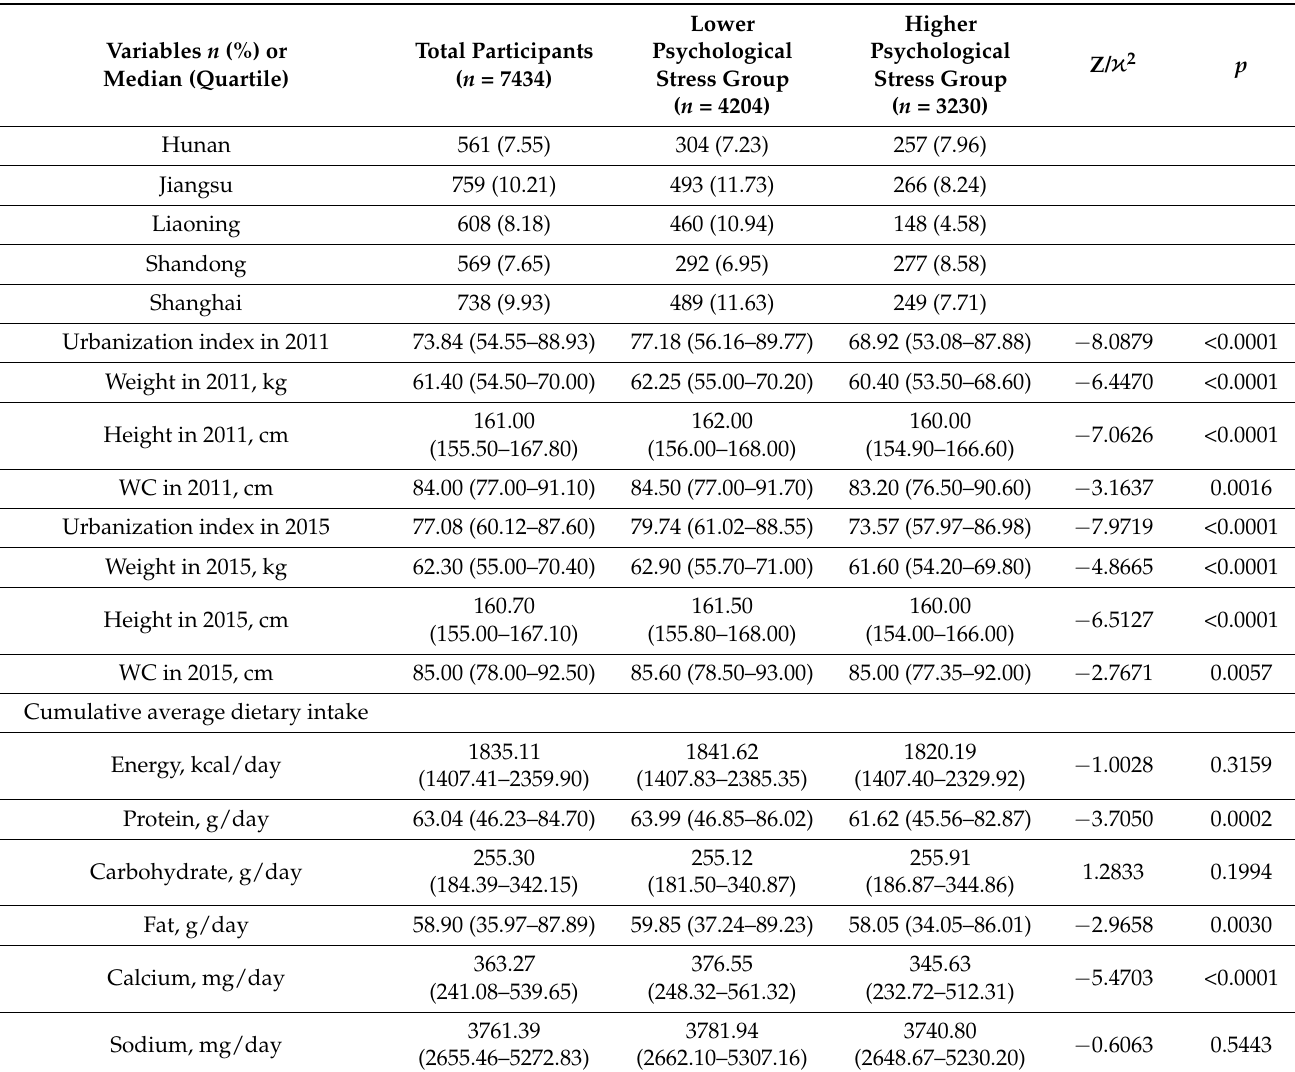
Table 1. Cont. Table 1. Descriptive statistics of